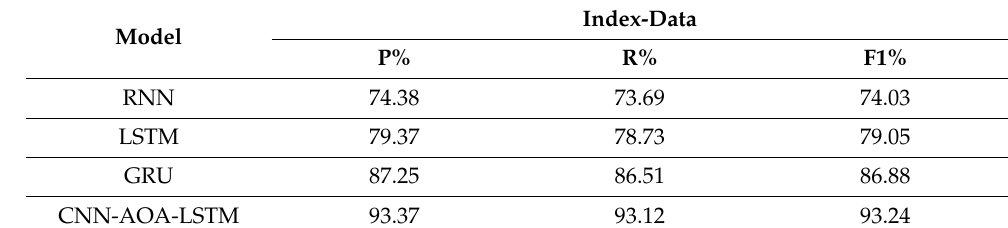
Table 2. Accuracy evaluation index of security risk level prediction.